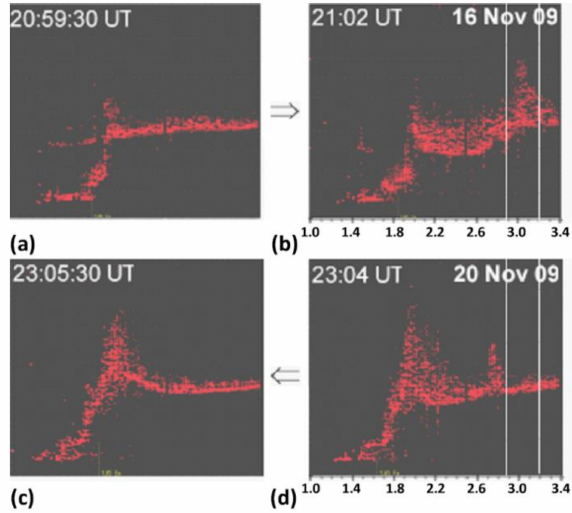
Figure 3. Comparison of ionograms recorded on 16 and 20 November 2009. ( a ) and ( c ) Recorded 30 s before the heater turned on and 90 s after the heater turned off; ( b ) and ( d ) recorded at the beginning of the moment when the O mode heater turned